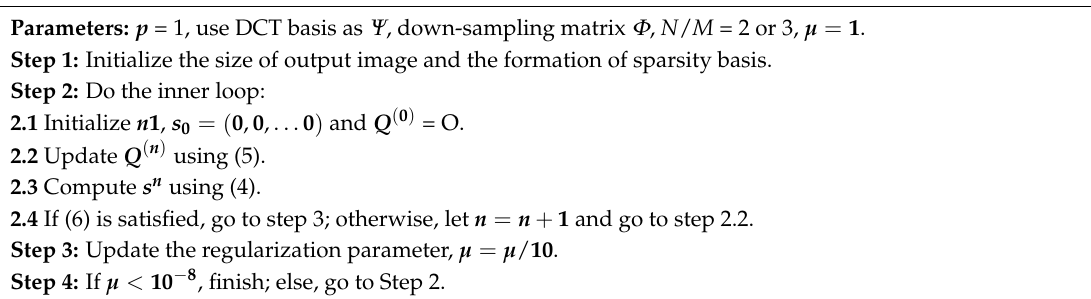
Algorithm 1. IRLS Method for